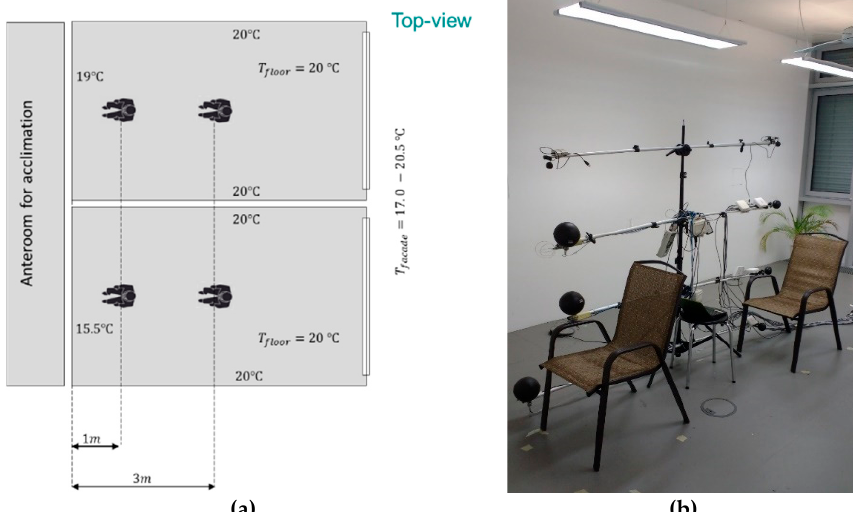
Figure 3. ( a ) Schematic of the LOBSTER (the two test-rooms and the anteroom) and ( b ) view into one of the two offices at the LOBSTER which demonstrates the positions of the participants in respect to the front walls (artificial windows) and the position of sensors.